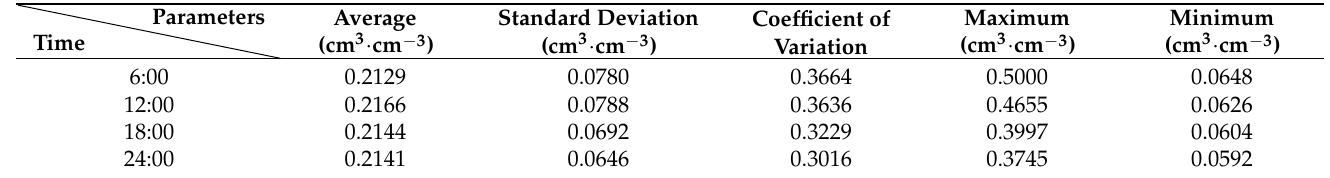
Figure 11. Simulation of soil moisture content distribution at different times after 1 day of irrigation. ( a ) 6:00 soil moisture content; ( b ) 12:00 soil moisture content; ( c ) 18:00 soil moisture content; ( d ) 24:00 soil moisture content. Table 8. Calculation of statistical indexes of soil moisture content for water storage pit irrigation day.